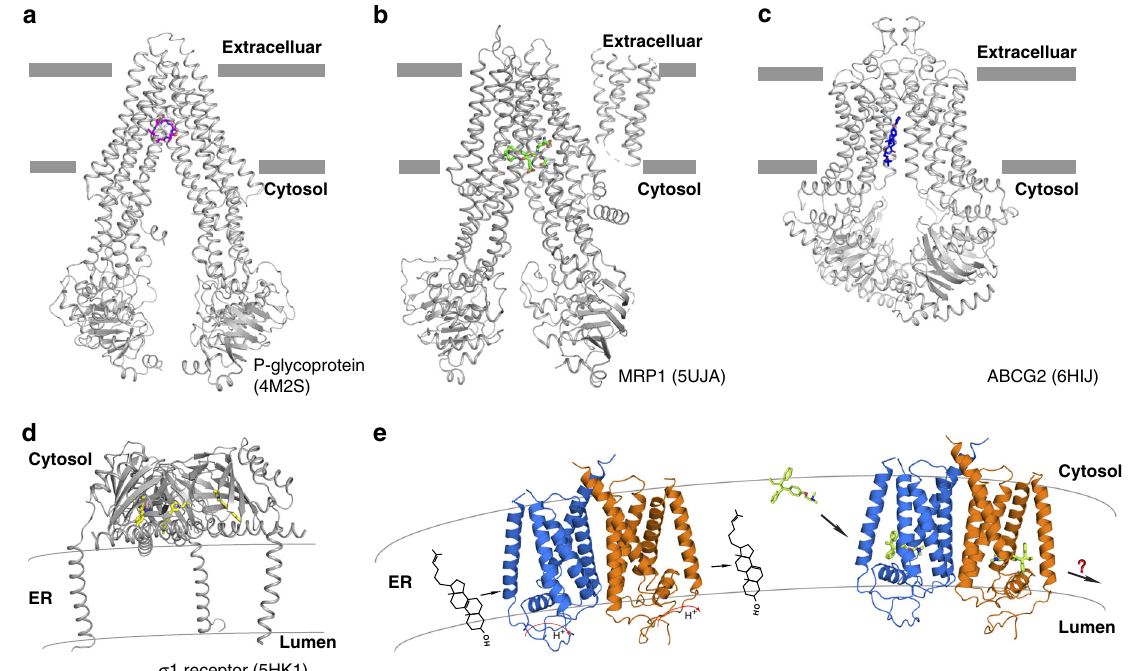
Fig. 6 Structural comparison of EBP with other membrane proteins known to cause drug resistance. a Overall structure of P-glycoprotein (PDB code: 4M2S). The two lines show the approximate location of the lipid bilayer. The ligand is shown in stick representation. b Overall structure of MRP1 (PDB code: 5UJA). c Overall structure of ABCG2 (PDB code: 6HIJ). d Overall structure of σ 1 receptor (PDB code: 5HK1). e The dual role of human EBP in the ER